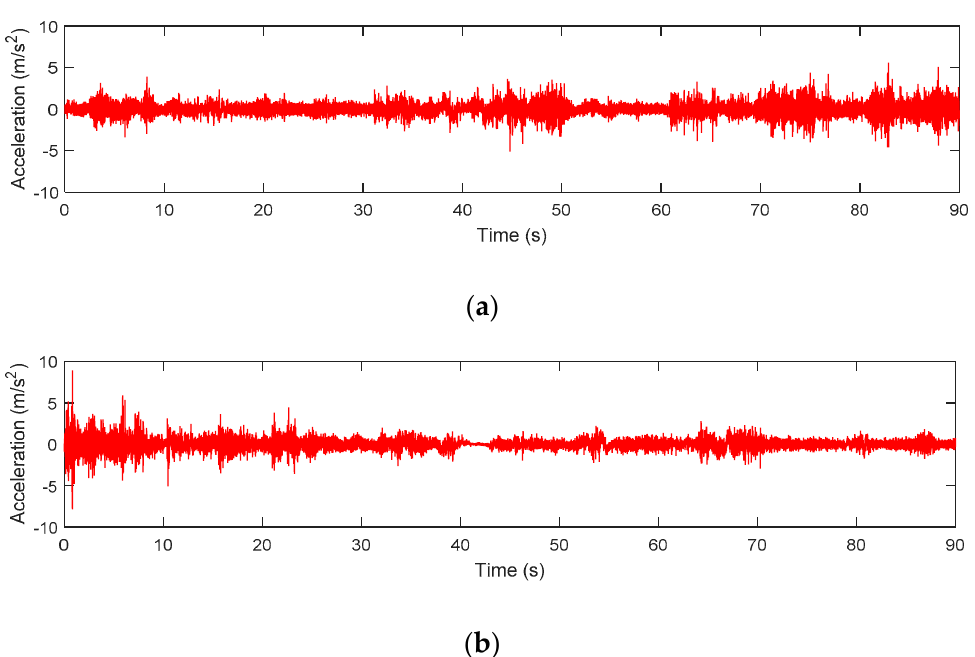
Figure 14. Top mount acceleration signals: ( a ) Campus A, ( b ) Campus B.